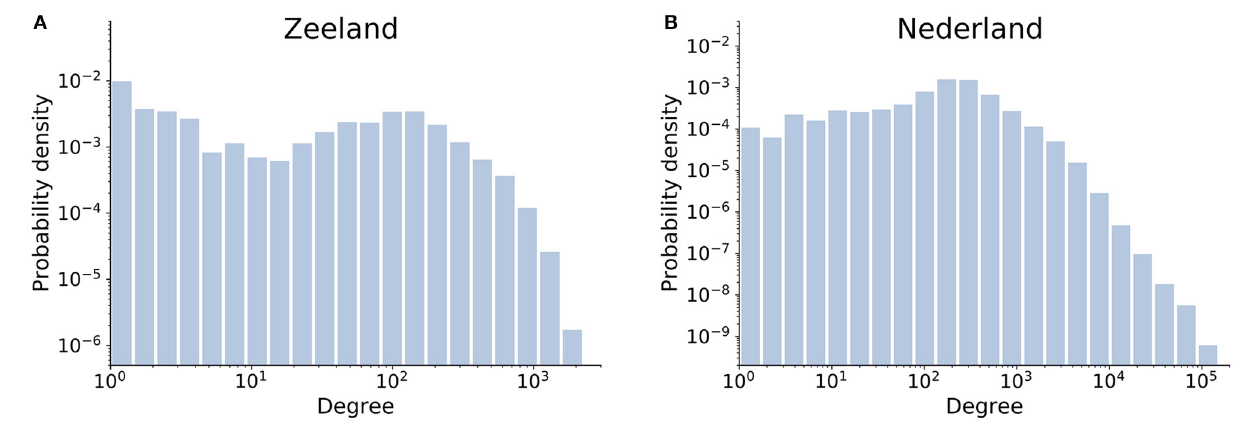
FIGURE 1 | Degree distributions of (A) Zeeland and (B) Netherlands production networks reflecting the unique, unweighted, undirected (inferred) trade relationships among companies with 5 +